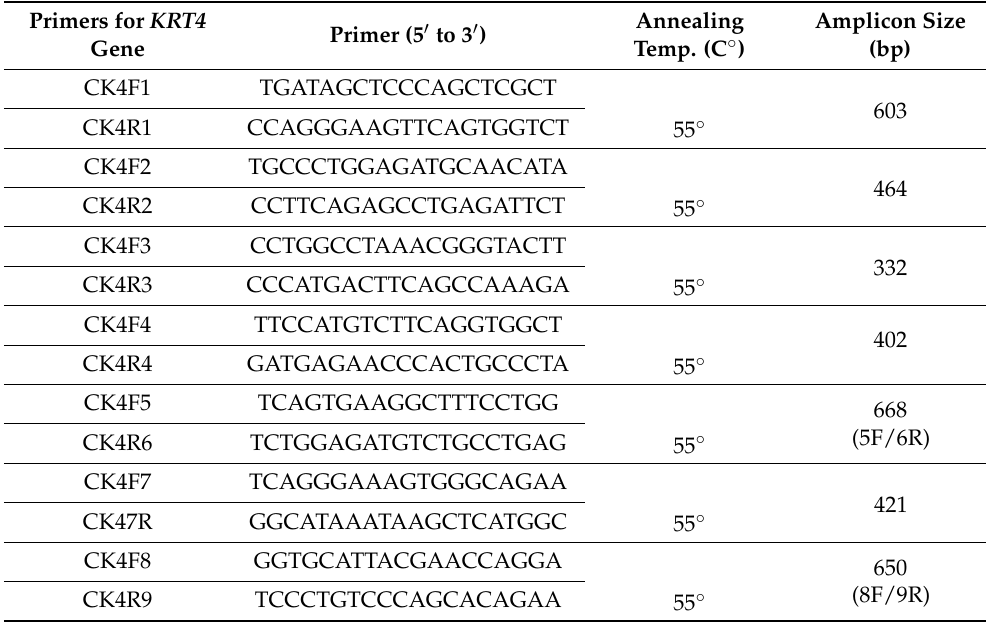
Figure 1. Clinical appearance of the same patient (right cheek ( A) , left cheek ( B ), right tongue ( C ), left tongue ( D ) with White Sponge Nevus: the mucosa appears bilaterally whitish, thickened and spongy texture. Table 2. List of PCR primer pairs and annealing temperatures used in the present study (F, Forward primer; R, reverse primer) and size of